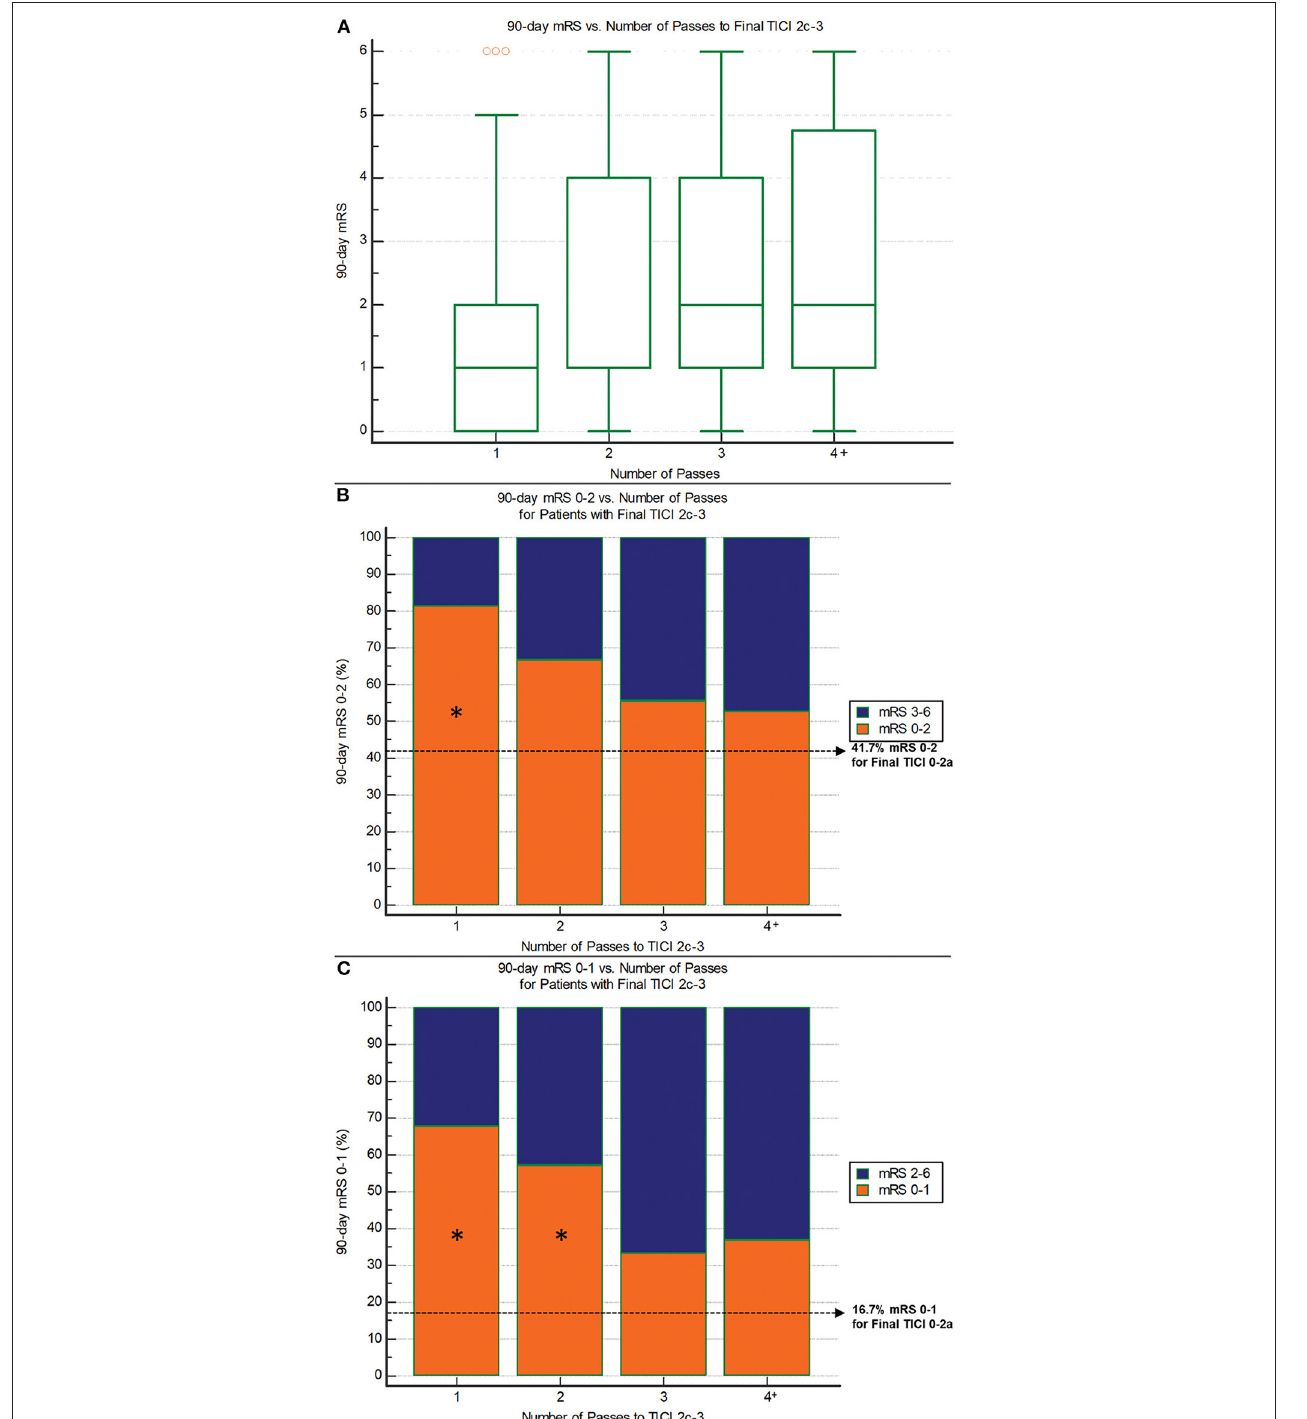
FIGURE 3 | 90-day outcomes vs. the number of passes required to reach final TICI 2c-3 reperfusion. (A) 90-day mRS: There are significantly lower mRS scores with fewer passes ( P = 0.0001; Jonckheere-Terpstra trend test). (B) 90-day mRS 0–2: There are progressively lower rates of good outcome with increasing number of passes ( P = 0.005; Chi-squared test for trend). Asterisk indicates significant difference compared to non-reperfusers (final TICI 0-2a). (C) 90-day mRS 0–1: There are progressively lower rates of excellent outcome with increasing number of passes ( P = 0.003; Chi-squared test for trend). Asterisk indicates significant difference compared to non-reperfusers (final TICI